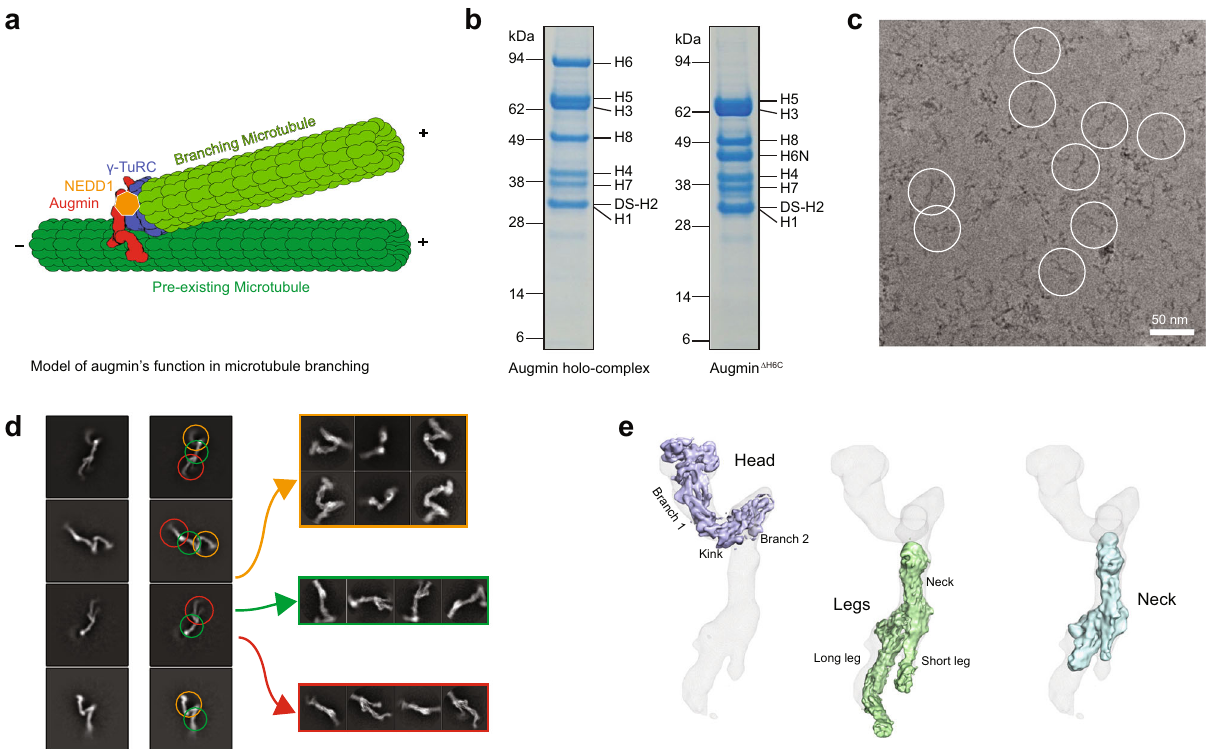
Fig. 1 | Puri fi cation and cryo-EM reconstruction of augmin. a A diagram of augmin – γ -TuRC – NEDD1 binding to pre-existing microtubules to create shallow- angled branching microtubules. b Representative SDS – PAGE gels of augmin holo- complex and augmin Δ H6C . The results shown are representative of more than three experiments. The uncropped gel is provided in the Source Data fi le. c Representative cryo-EM micrograph of augmin Δ H6C from a total of 20,021 micro- graphs. Scale bar 50nm. Examples of augmin particles are circled. d 2D